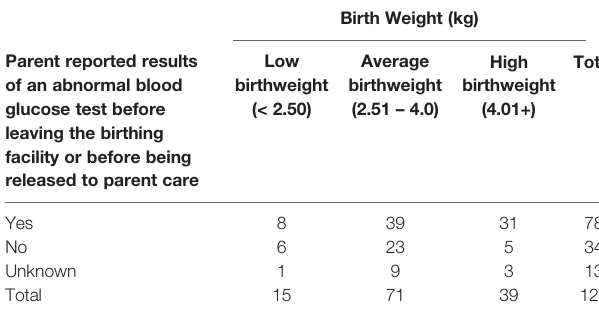
TABLE 4 | Abnormal blood glucose recorded before leaving facility, by birth